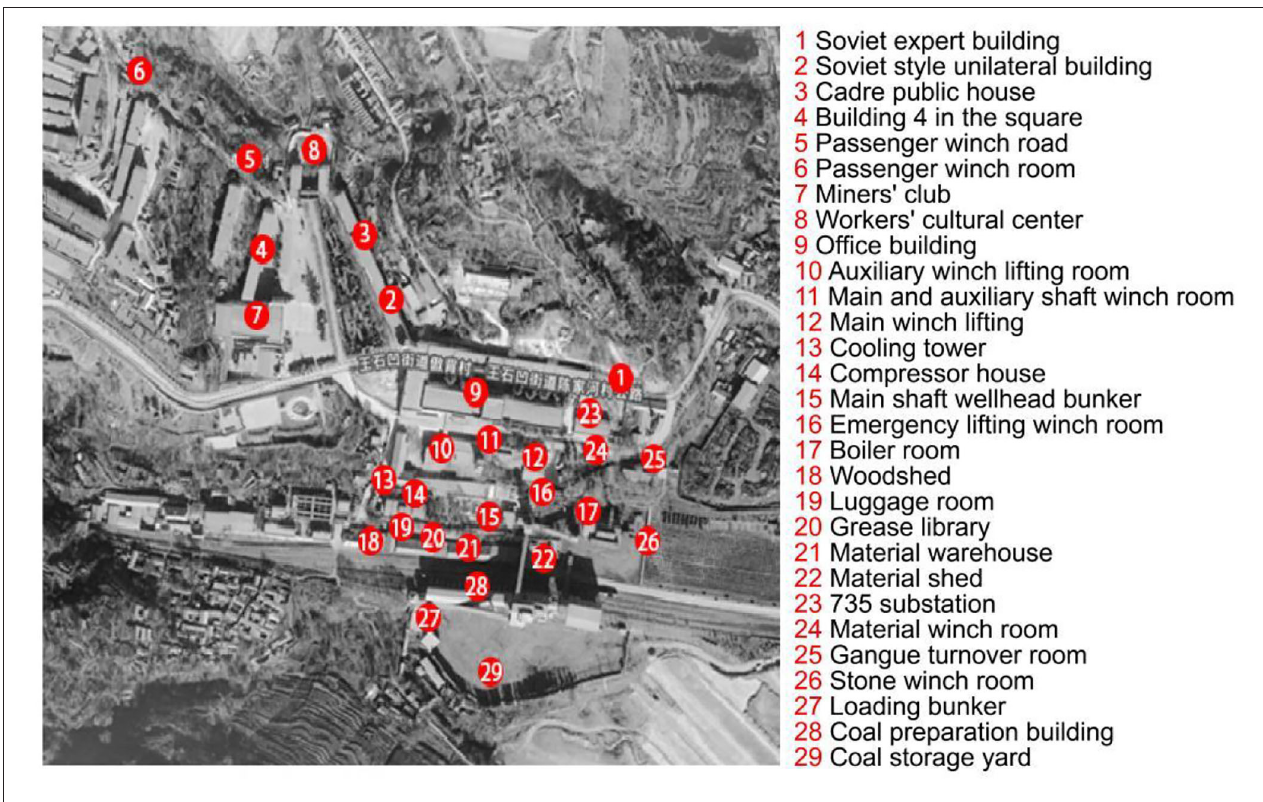
FIGURE 2 | Layout of Wangshiwa Heritage.